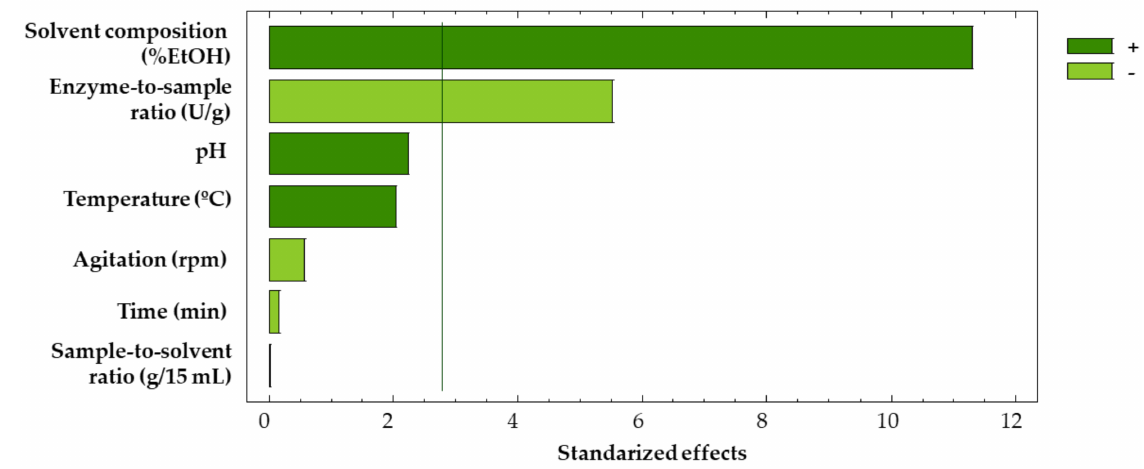
Figure 2. Pareto diagram of the Placket–Burman screening design. The plot corresponding to the most significant effect (Figure 3) allows us to determine the value that should be assigned to each factor for further analysis. As the extraction yields were maximized when ethanol-rich solvents were used, the range of values to be studied was adjusted from 0 − 40% to 20 − 60% in order to determine if higher ethanol percentages would lead to greater extraction yields. With regard to the rest of the factors, the values to be considered remained unchanged.